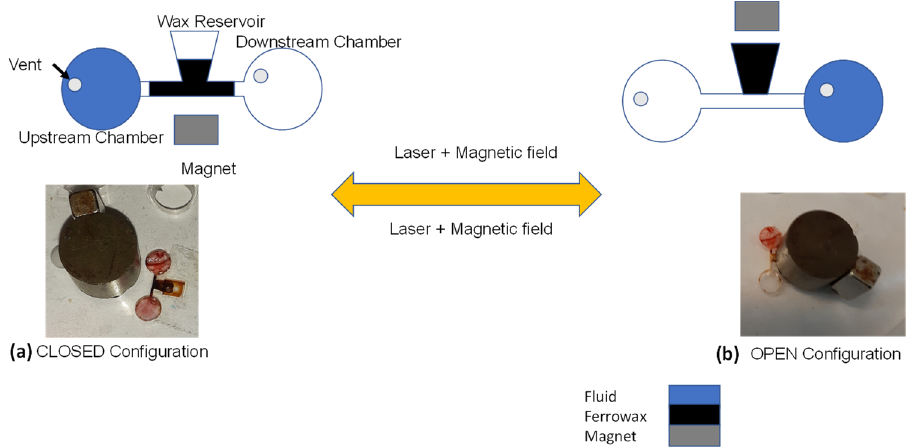
Figure 12. Magnet ‐ based ferrowax microvalve. ( a ) the magnet near the valving channel, which attracts the molten ferrowax (melted with laser), creating a closed configuration of the valve. ( b ) Magnet near the wax reservoir, which collects the molten wax in the reservoir opening the valve to open configuration of the valve. The figure was reconstructed from a source cited [44].